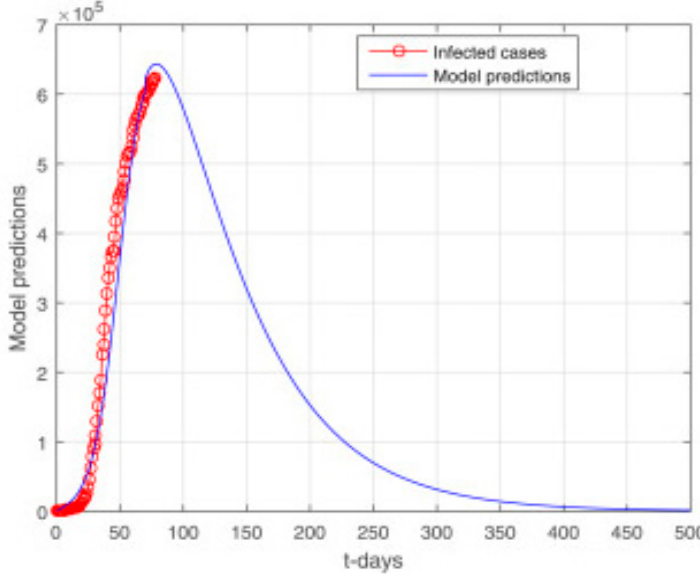
Figure 9. Model prediction using real data.